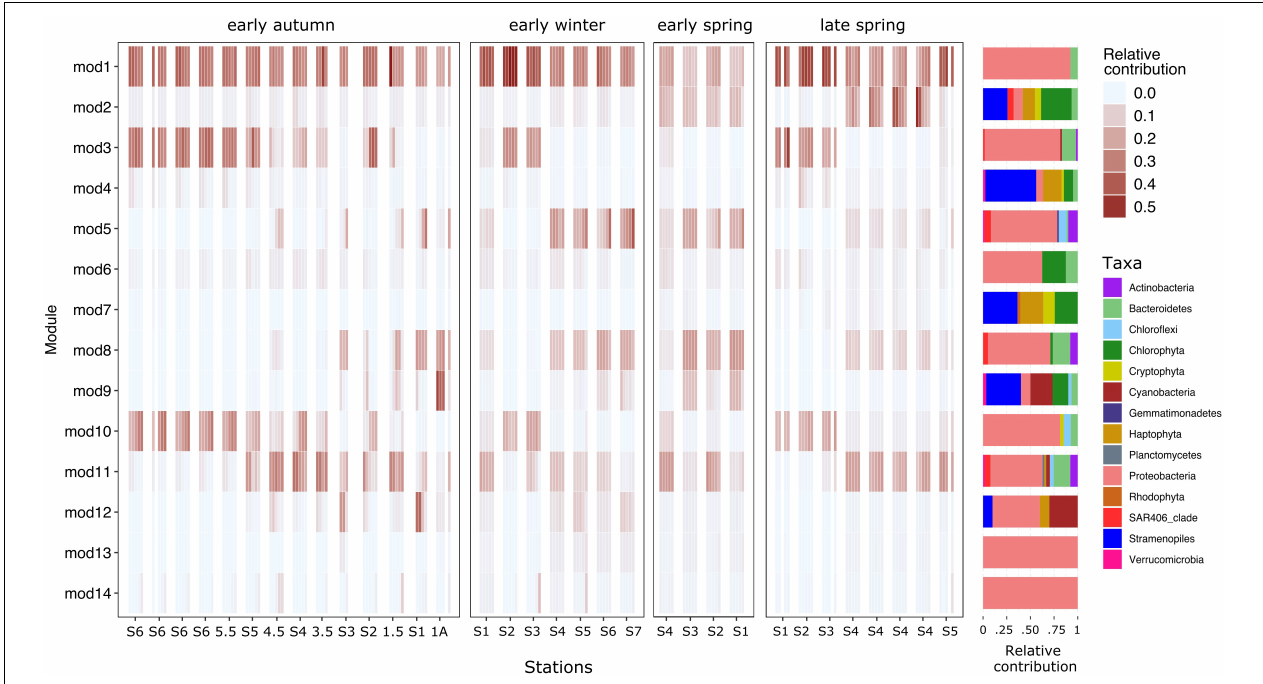
FIGURE 8 | Heatmap depicting the relative contributions in the euphotic zone of each network’s module to the total dataset. Modules are organized in sequential numbers from top to bottom in the x -axis. Samples are displayed in the y -axis; organized following the same order as in Figures 3–6 . Only ASVs from the upper 100 m samples were analyzed. The percentage represented by the heatmap is restricted to the total reads of ASVs used in the network analysis. Aligned barplots on the right side of the heatmap represent the taxonomic relative contribution of the ASVs to the